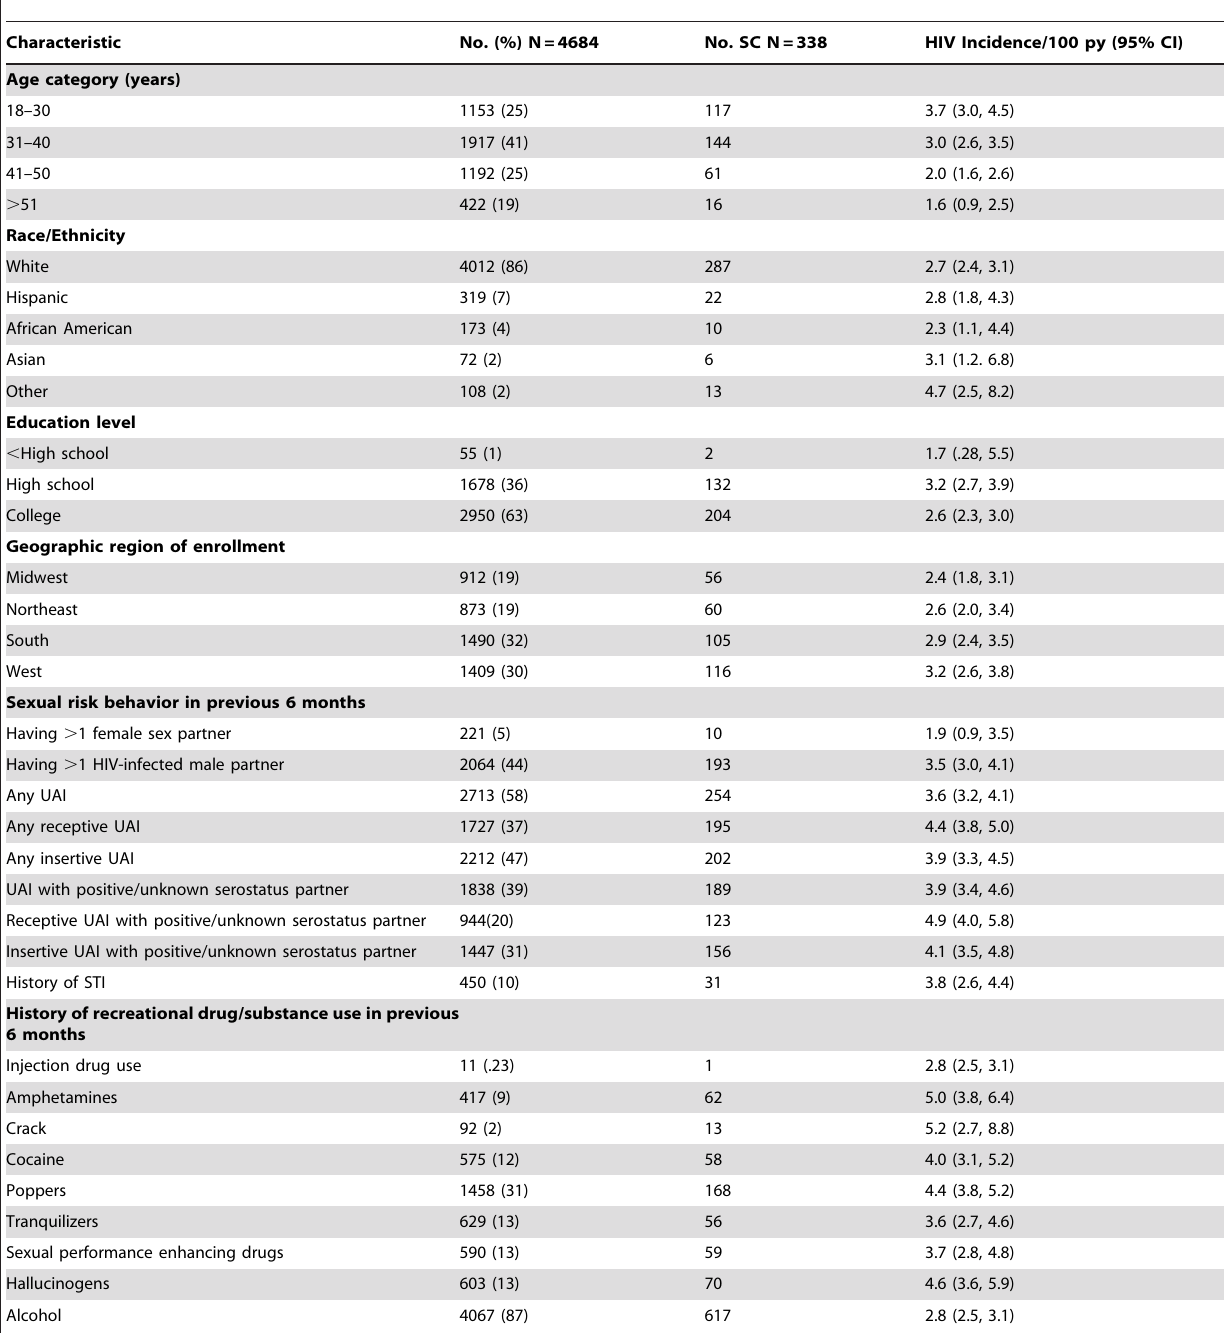
Table 1. US MSM HIV seroincidence (per 100 person-years) by participant demographic and behavioral characteristics at enrollment